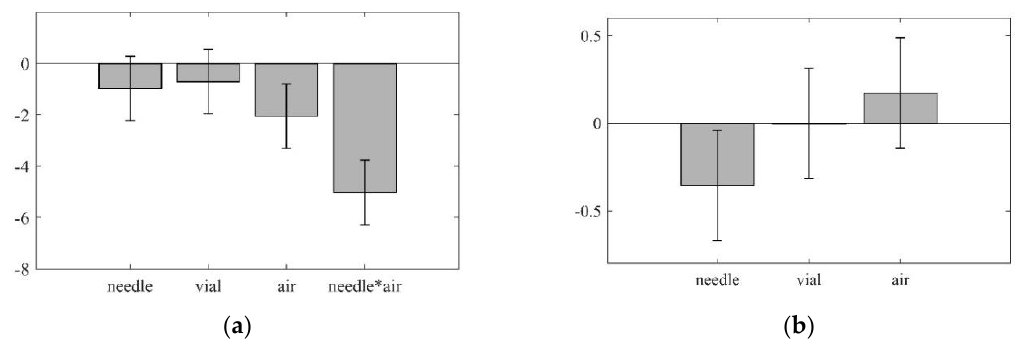
Figure 5. The coefficient plot ( a ) of the Partial Least Squares (PLS) regression shows the correlation of the different washing procedures on the precision of the derivatization method. The air draw before addition of the next reagent as well as an interaction term of needle wash and air draw show a negative correlation, i.e., these washing procedures result in a higher precision of the method. The underlying model has an R 2 of 0.962 and a Q 2 of 0.477. The coefficient plot ( b ) shows the correlation with the method accuracy. Only needle wash shows a significant negative correlation, i.e., a positive impact on accuracy. The underlying model has an R 2 of 0.590 and a Q 2 of −0.200.